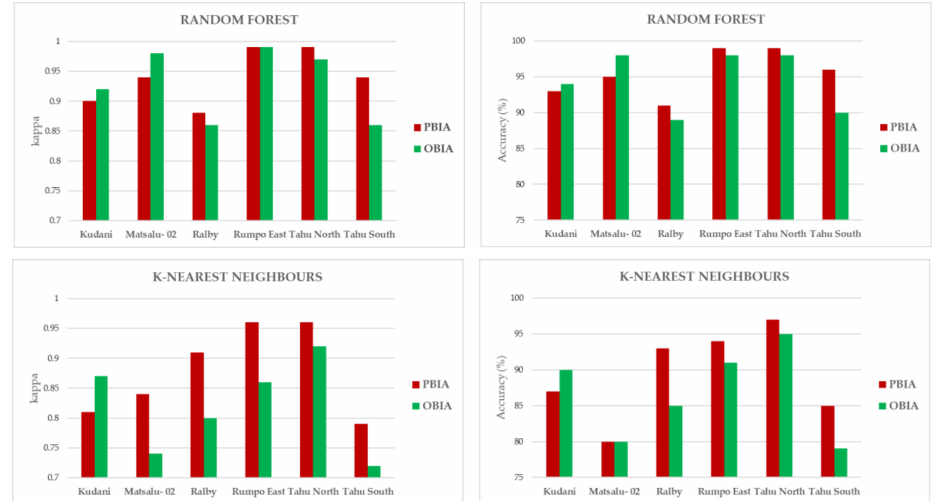
Figure 4. Classification assessment. ( Above ), the kappa statistic ( left ) and accuracy ( right ) of Random Forest; ( Below ), the kappa statistic ( left ) and accuracy ( right ) of K-Nearest